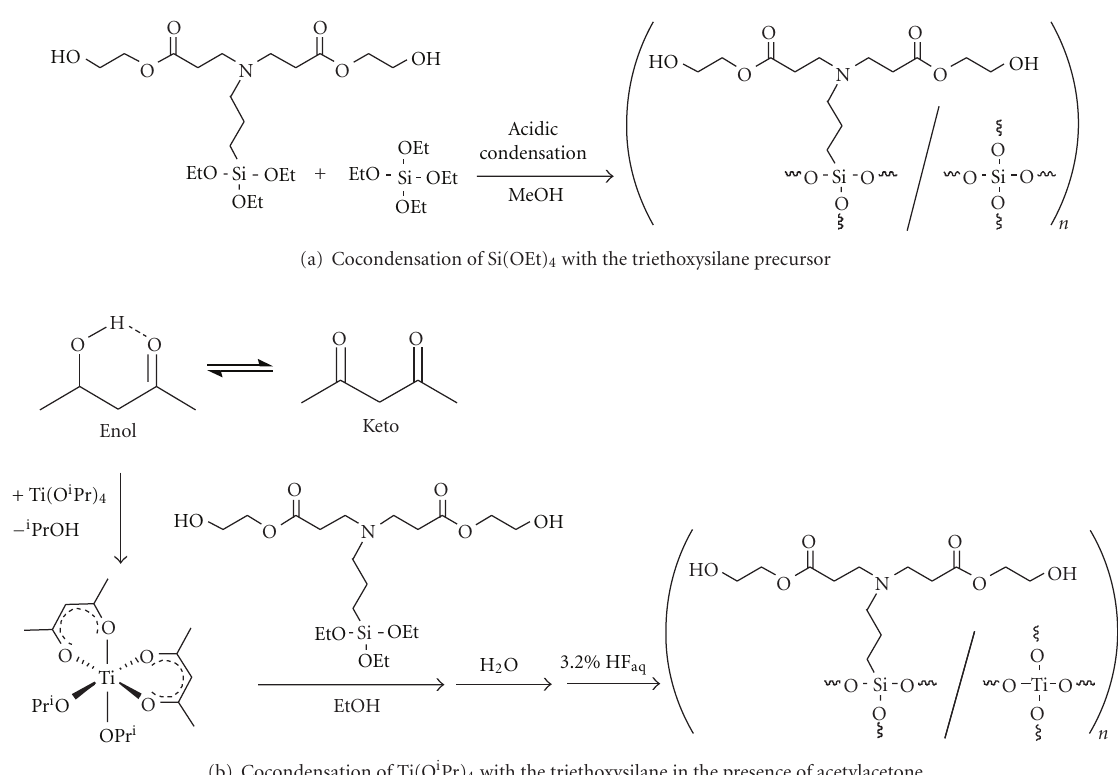
Figure 6: Synthesis of hybrid nanoparticles by cocondensation of the hydroxyl-functionalized triethoxysilane precursor derived from 2-hydroxyethyl acrylate